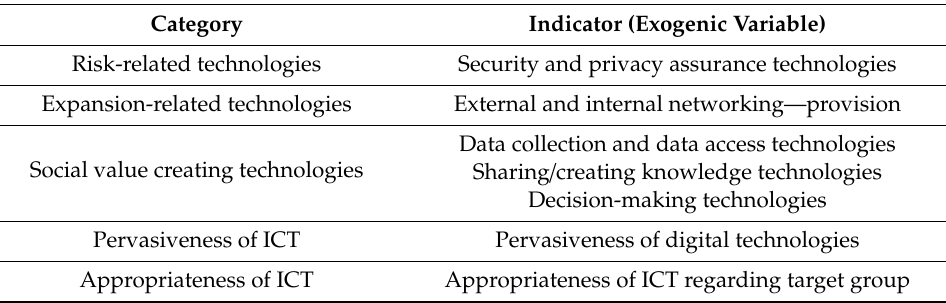
Table A2. The structure of Digital Inclusiveness